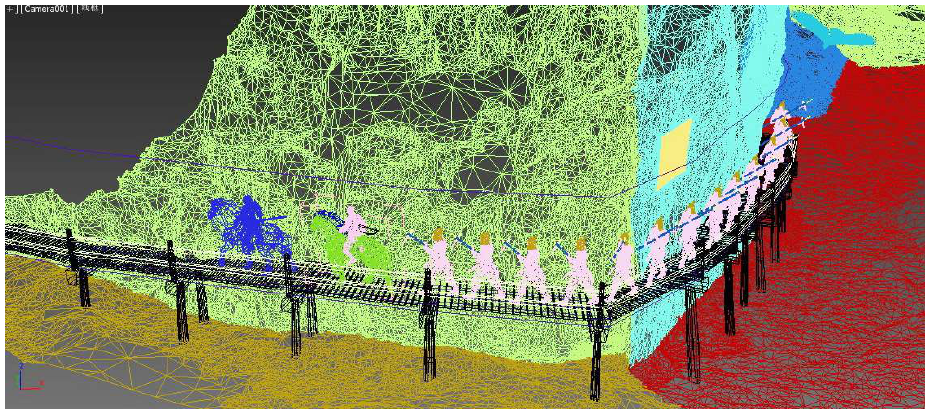
Figure 13. Adding of the components and the background of the plank road to a three-dimensional